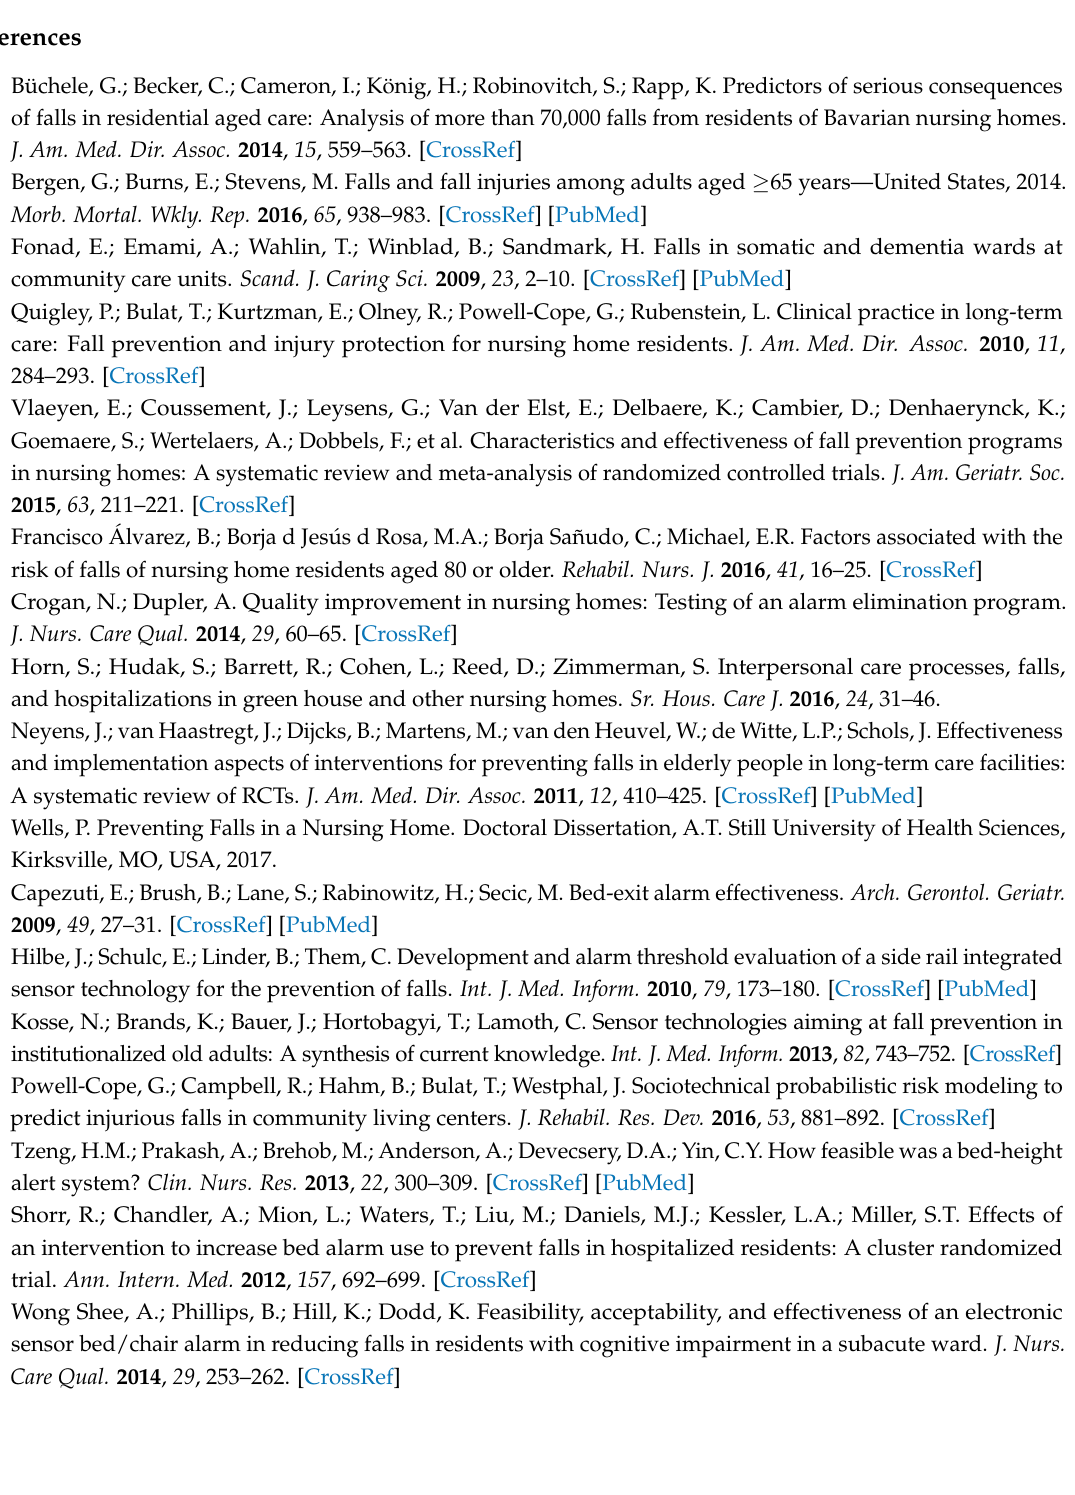
Table S1: Literature review